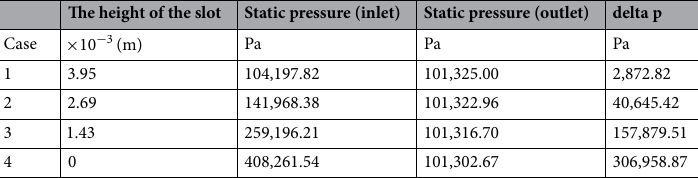
Table 4. Static pressure losses in the considered flow